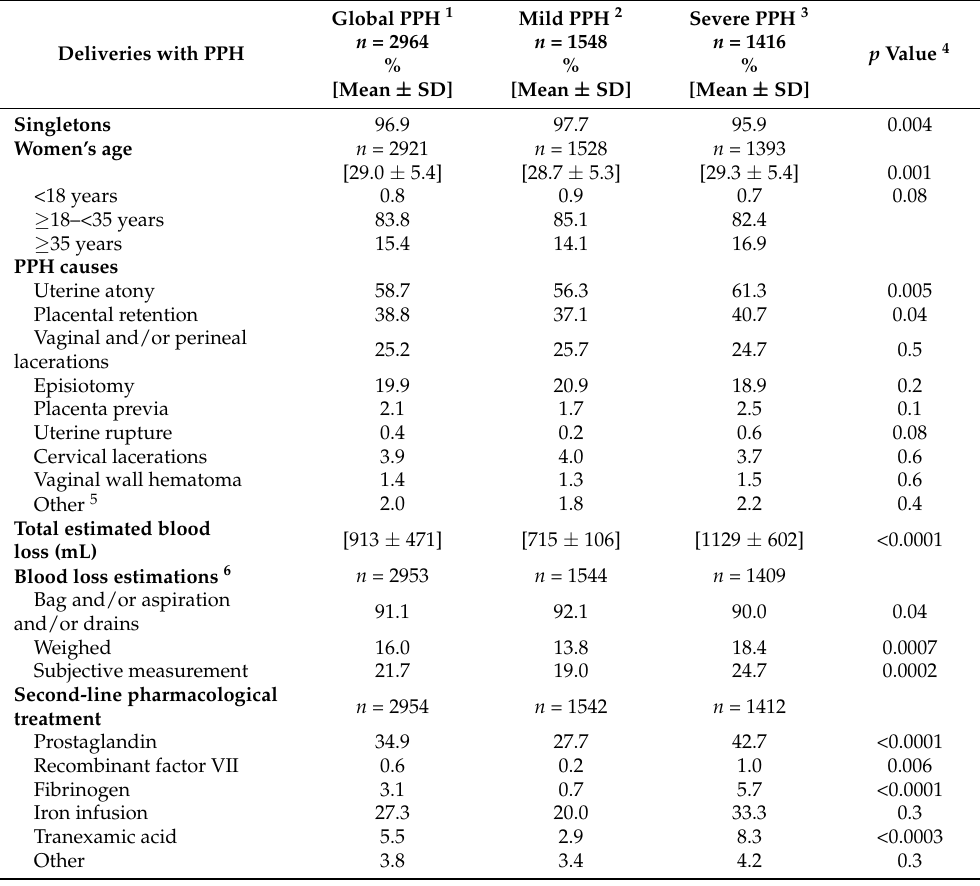
Table 1. Women’s characteristics overall and by severity of the postpartum